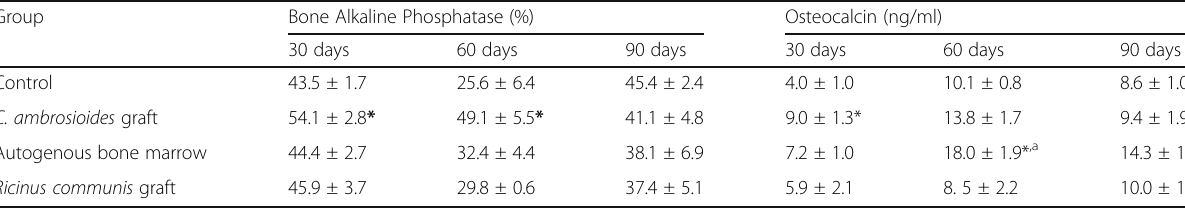
Table 2 Comparison of bone alkaline phosphatase and osteocalcin after the application of Chenopodium ambrosioides L. Group